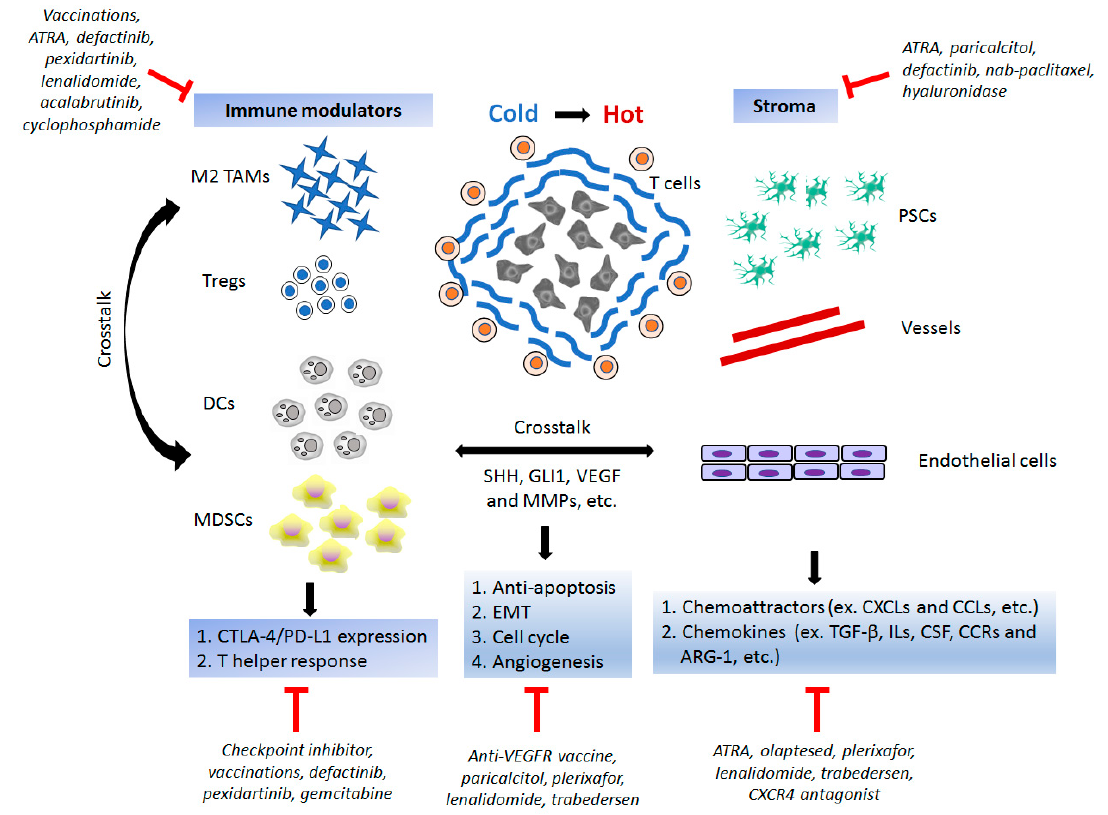
Figure 1. The response to immunotherapy in pancreatic ductal adenocarcinoma (PDAC) relies on destroying cancer cells as well as on breaking the stromal barrier and flaring up immune function. Immunotherapy targeting the PD-1/PD-L1 pathway and TME has disrupted the traditional method of cancer treatment and countered the immune-related adverse events in patients. In addition to direct cytotoxicity on cancer cells, it is important to dissect the immunosuppressive microenvironment with various cytokines and immune cells. Furthermore, recognition of mechanisms modulating the PD-1/PD-L1 pathway and TME will identify more potential therapeutic targets in the future.